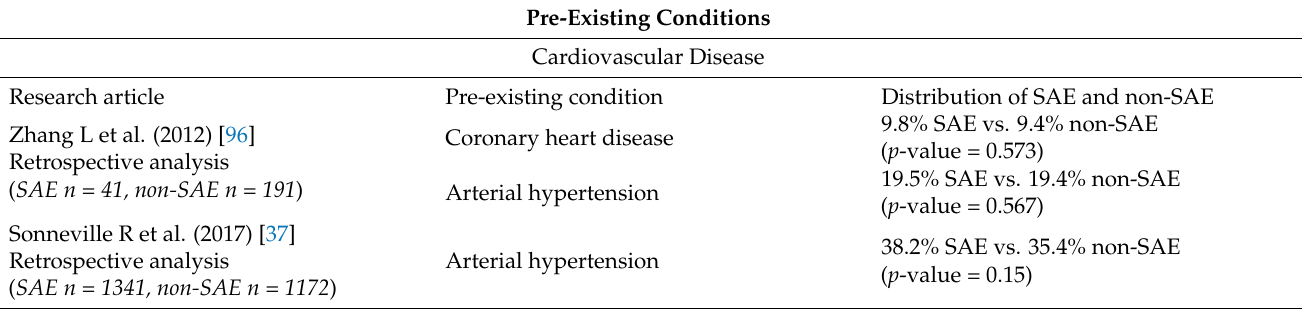
Table 2. Pre-existing conditions leading to